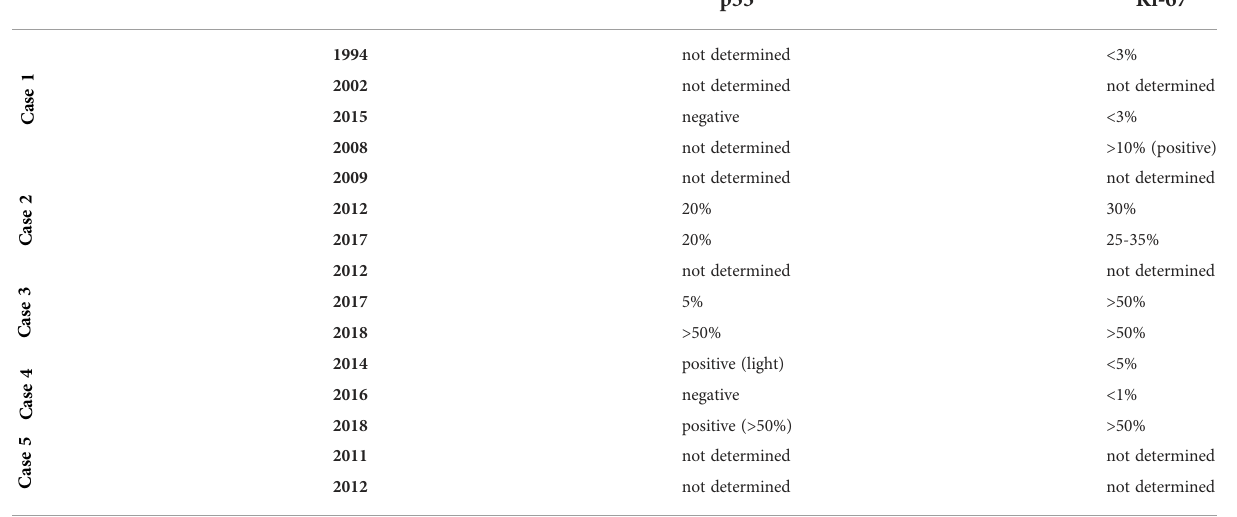
TABLE 3 Overview of the evolution of p53 and Ki-67 in the different